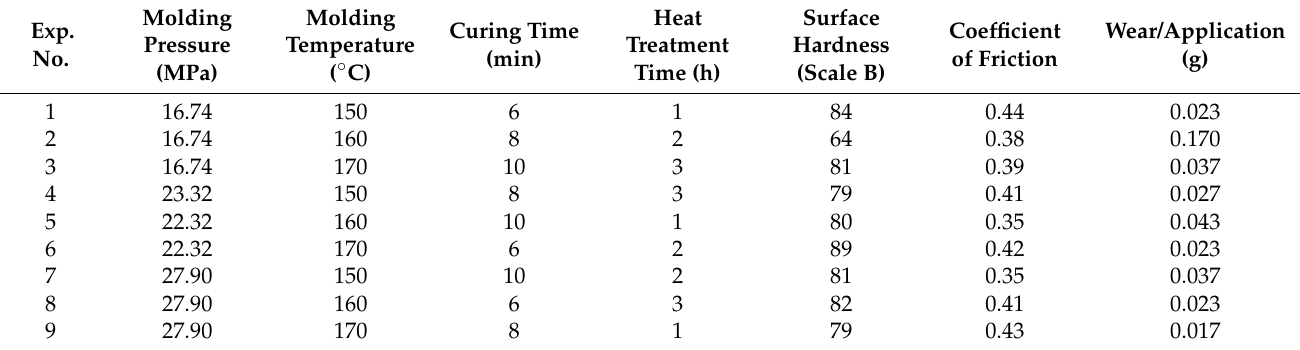
Table 4. Experimental design plan and responses for case study 2